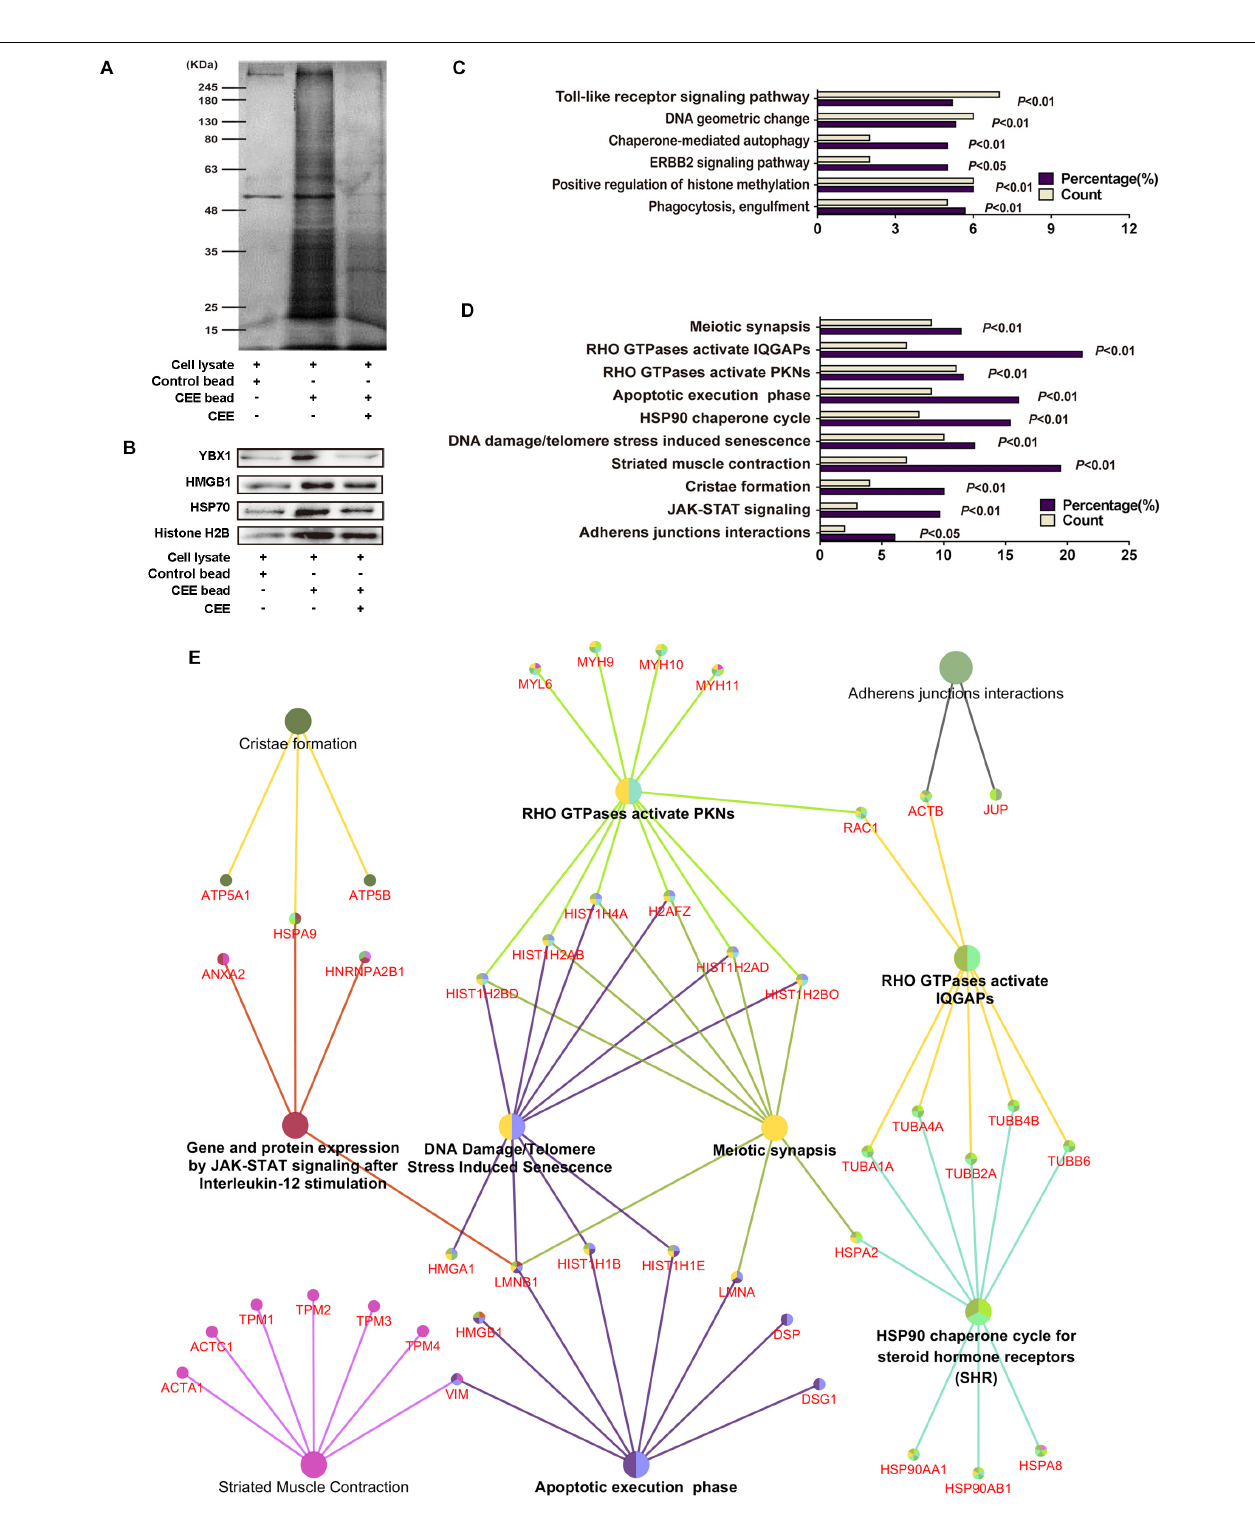
FIGURE 5 | Direct target protein identification and neuroprotective pathway-gene network analysis of CEE. (A) The potential target proteins were captured by the CEE-coated beads, separated by 10% SDS-PAGE, and then visualized by silver staining. (B) The expression of YBX1, HMGB1, HSP70, and Histone H2B were detected by western blotting. (C) 150 potential target proteins were identified by LC-MS/MS and classified into 6 GO terms in biological processes. (D) 150 potential target proteins were classified into 10 terms in reactome pathways. (E) The pathway-gene network comprised of 150 potential target proteins. The analysis was based on the Homo sapiens gene annotation databases, more than two genes in each term and P -value < 0.05.